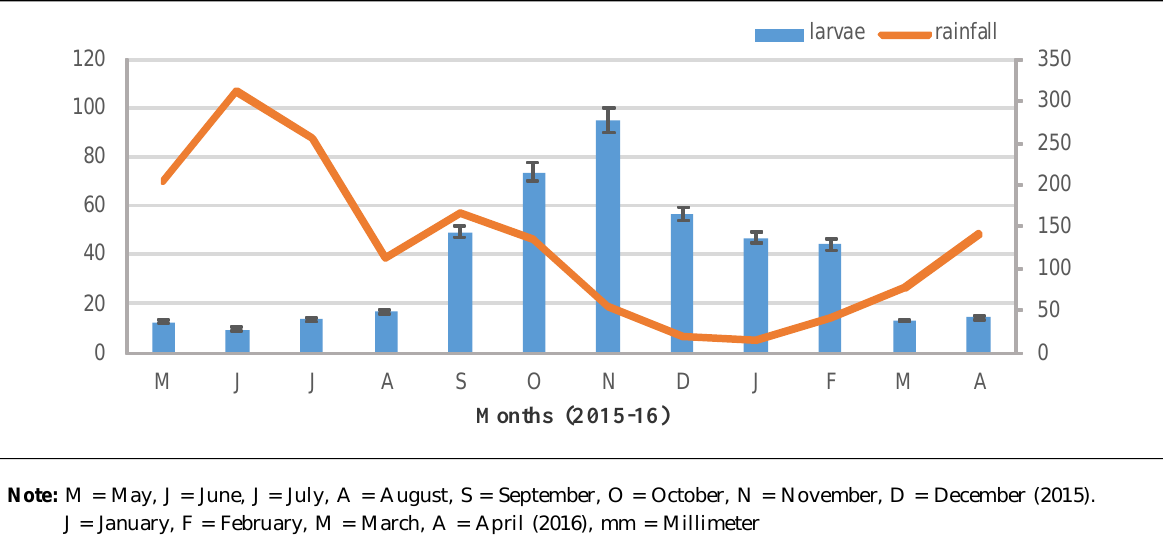
Figure 1: Population dynamics of Cx. quinquefasciatus larvae in the four selected LGAs of Lagos state Kosofe LGA recorded the highest number of Culex larvae (33.9%), followed by Ojo LGA (28.6%) and Eti-Osa LGA (21.3%), while Epe LGA (16.2%) recorded the least mosquitoes. There was a significant difference in larval population in all the study areas ( F = 6.12, p = 0.001, p < 0.01). The larval abundance differed significantly between Kosofe and Epe LGAs and Kosofe and Eti-Osa LGAs. There was also a significant difference between the number of larvae collected in Ojo and Epe LGAs. However, the larval population did not vary statistically between Kosofe and Ojo LGAs, Ojo and Eti-Osa LGAs and Eti-Osa and Epe LGAs (Figure 2).